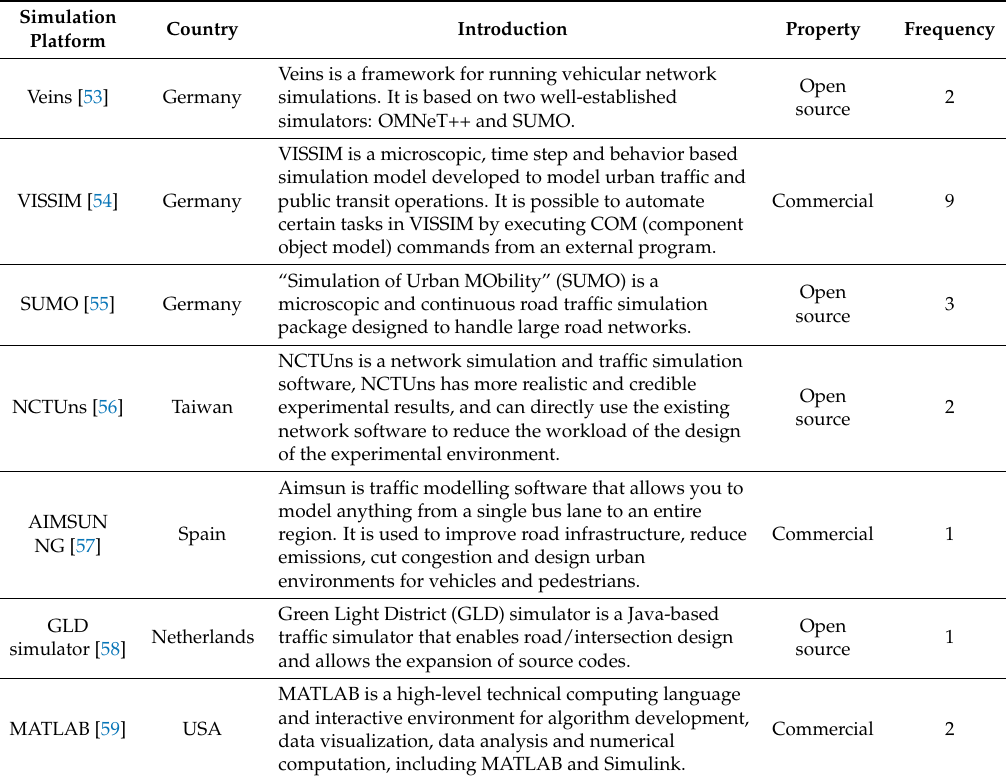
Table 4. Summary of simulation platform and basic description in the selected